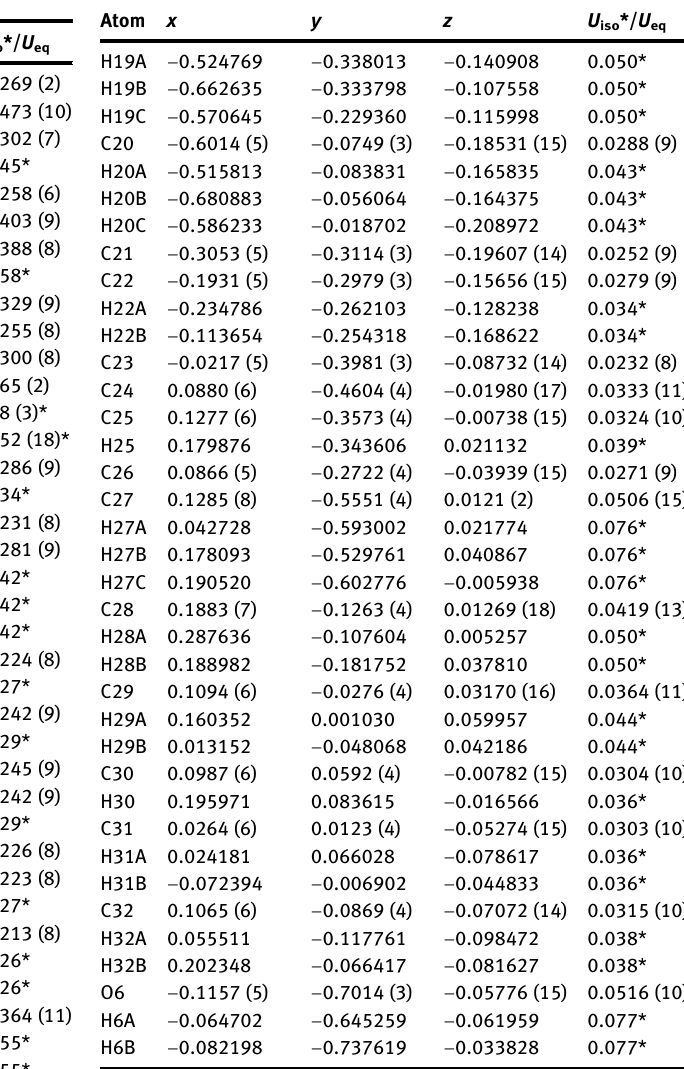
Table  : Fractional atomic coordinates and isotropic or equivalent isotropic displacement parameters (Å 